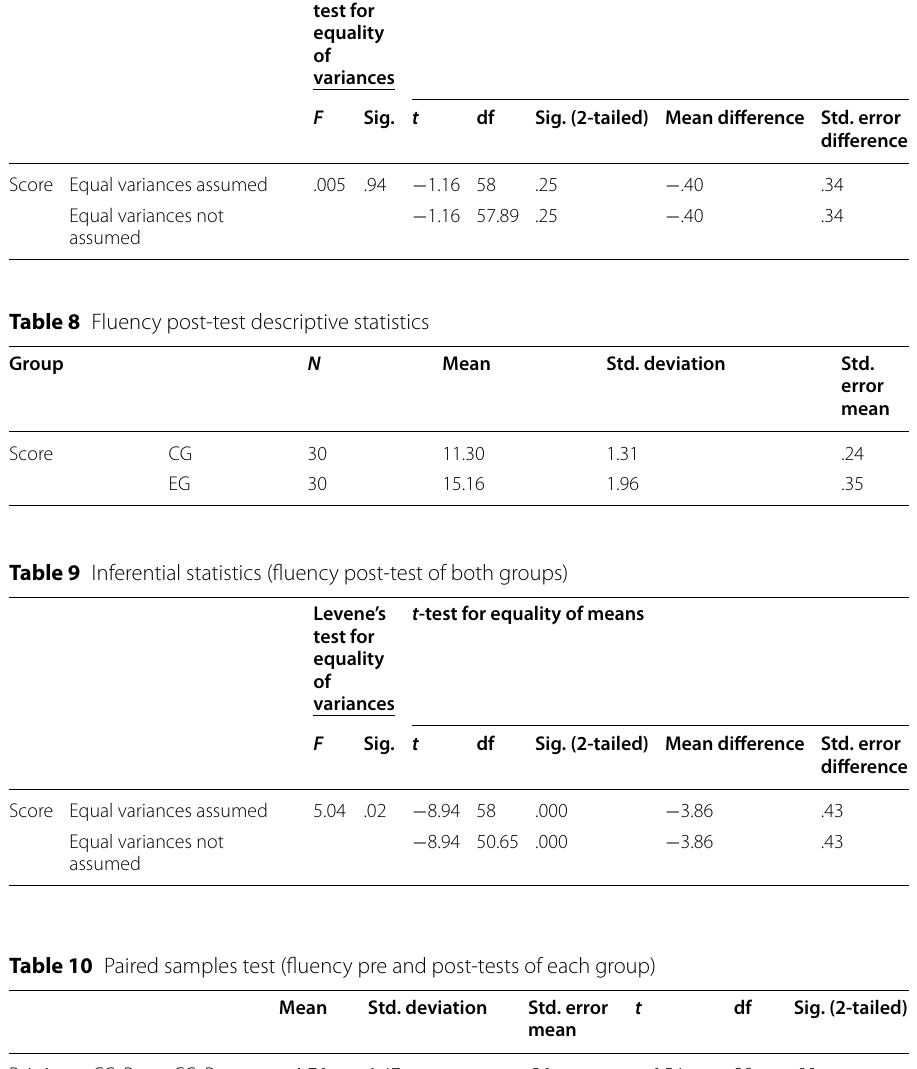
df Sig. (2-tailed) mean